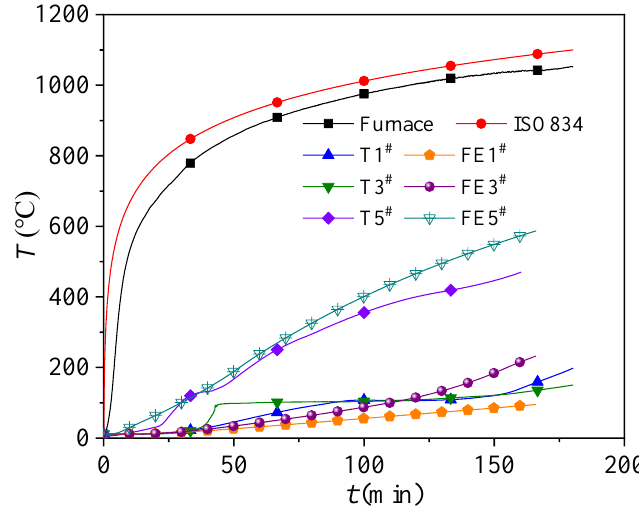
Figure 13. Comparison of the simulated and measured temperature for beam JJLH1.